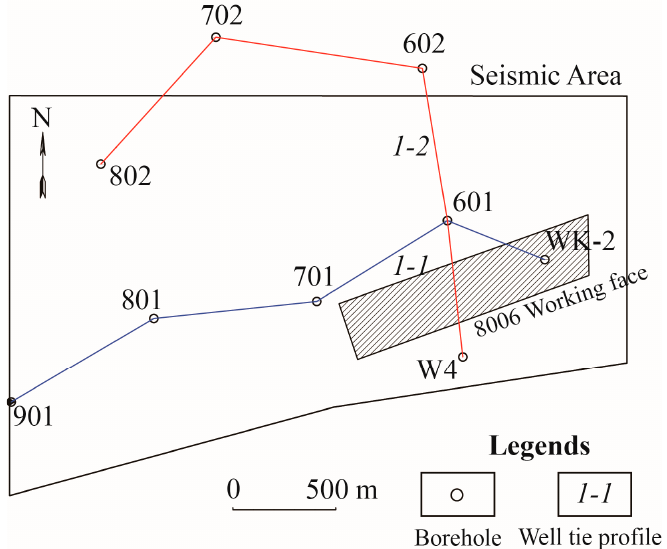
Figure 3. Seismic area.